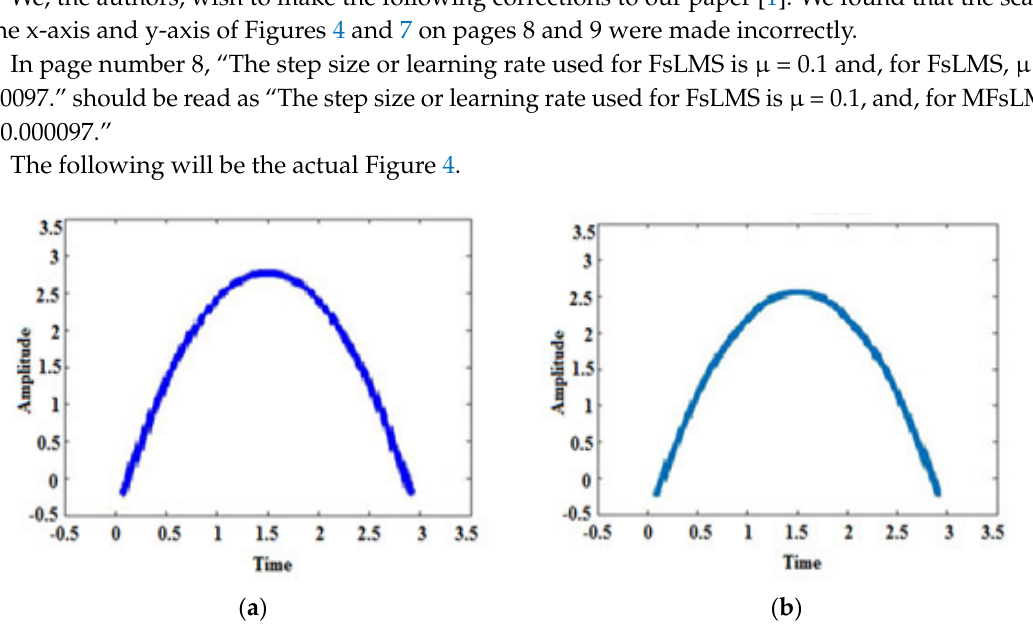
Figure 4. Signal after removing Noise from Figure 3. ( a ) Proposed method; ( b ) existing method.